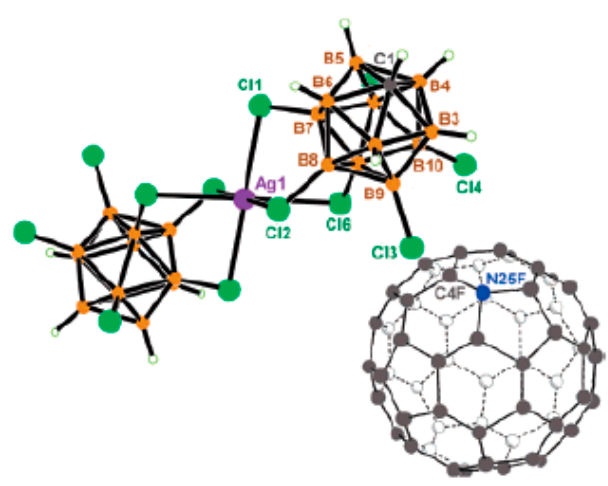
Figure 68. Structure of the {Ag[1-CB 11 H 6 -6,7,8,9,10,11,12-Cl 6 ]} − anion in [C 59 N]{Ag[1-CB 11 H 6 -6,7,8,9,10,11,12-Cl 6 ] 2 }·3( o -dichlorobenzene). Reprinted with permission from reference [96]. Copyright © (2003) American Chemical Society.